Question: What kind of plot is shown here?
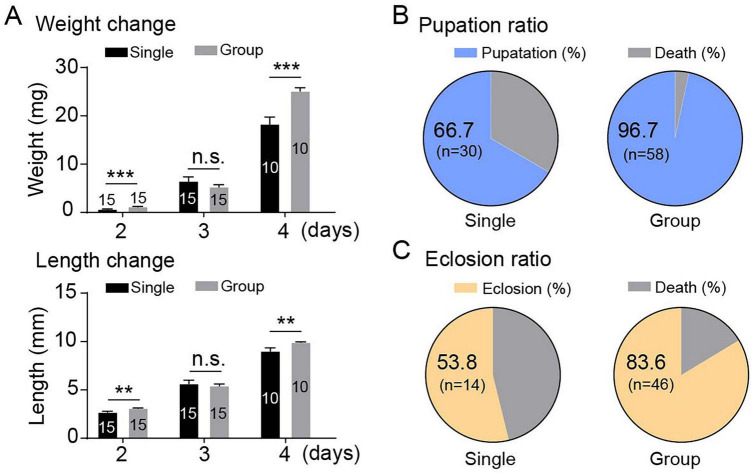
Answer: line